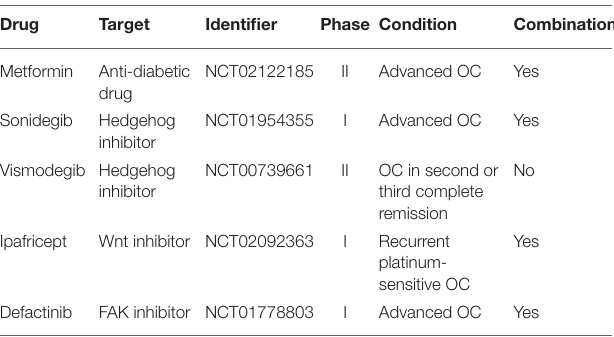
TABLE 2 | Emerging therapies targeting ovarian cancer stem cell-associated